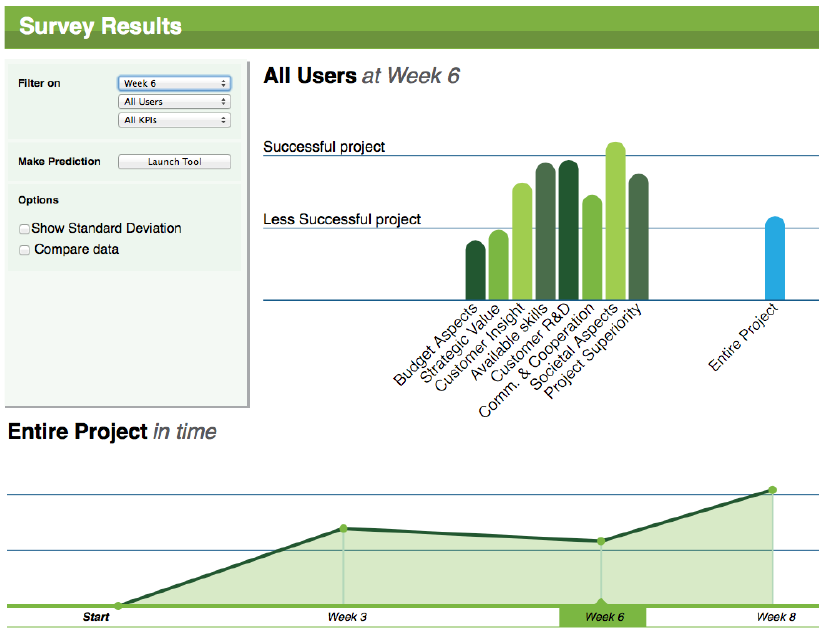
Fig. 5. Basic project overview dashboard with three distinct elements. The right part displays performance on various KPIs (green lines) and the overall project (blue line) in relation to successful and less successful previous projects (also see Figure 1). The bottom part displays overall project performance in time, an additional feature that allows for project quality monitoring. The top left part displays selectable project parameter display filters. From top to bottom, these are: project display selection, project evaluation moment, user selection, and specific KPI scores selection. Also, this part has buttons. One checkbox launches a dashboard in which projects can be compared to one another (Figure 2). The other launches a tool that estimates performance change when changing one KPI (see Figure